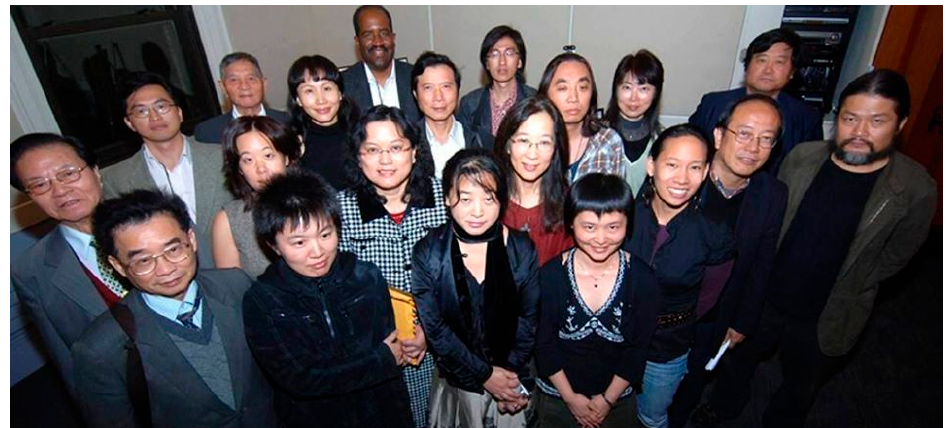
Figure 2. Simmons College Poetry Conference in 2004. Ye Mimi is in the first row, fourth from left. Shin Yu Pai is in the second row, second from left.